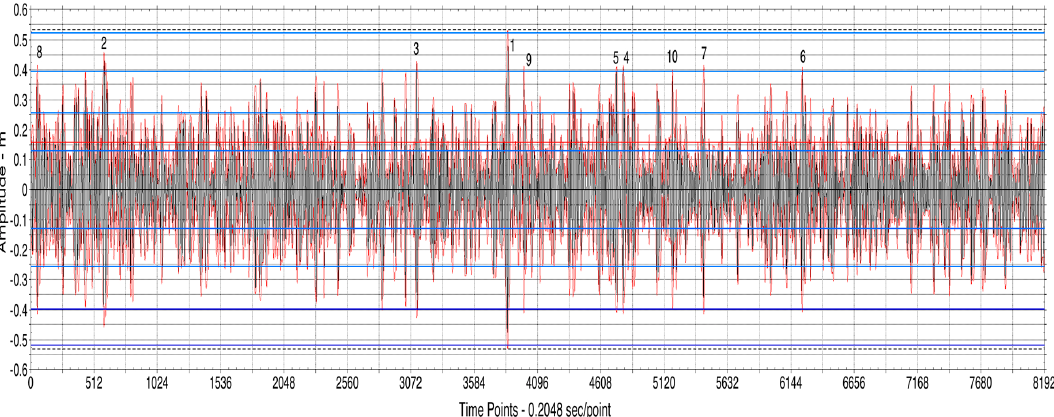
Figure 29. The measured time series of Figure 28 has been processed by the inverse nonlinear Stokes operator (Osborne et al. [5]) to obtain the present time series. As a consequence, the time series is up/down symmetric, the Stokes wave contribution has been removed, a condition consistent with further analysis using NLFA for the 1+1 NLS equation (see Figure 30). Also shown ( red ) is the 1/2 modulational envelope A ( 0, t ) = [ η ( 0, t ) 2 + (cid:101) η 2 ] found by the Hilbert transform of the above time series for which the carrier amplitude is ao 16 cm . The significant wave height of this time series is 52.0 cm. The height of the largest wave (labeled 1) is 2.04 H s . The numbers labeling the largest ten packets coincide with the largest packets in the NLFA spectrum shown in Figure 30. The largest three packets have central waves that are bigger than 2.2 H s and are therefore classifiable as rogue waves.